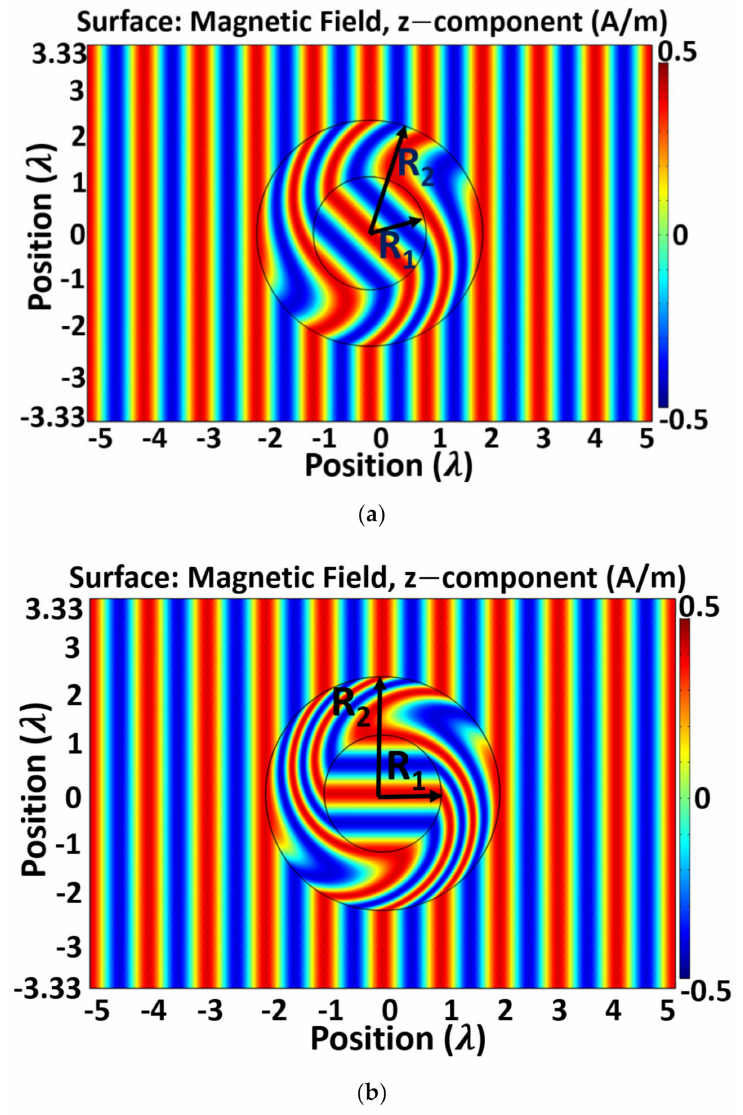
Figure 3. Verification of material parameters for TO-based cylindrical rotator showing perfect TEM wave with no scattering at the boundaries of the material region and free-space ( a ) at rotation angle β = 45 ◦ , ( b ) at rotation angle β = 90 ◦